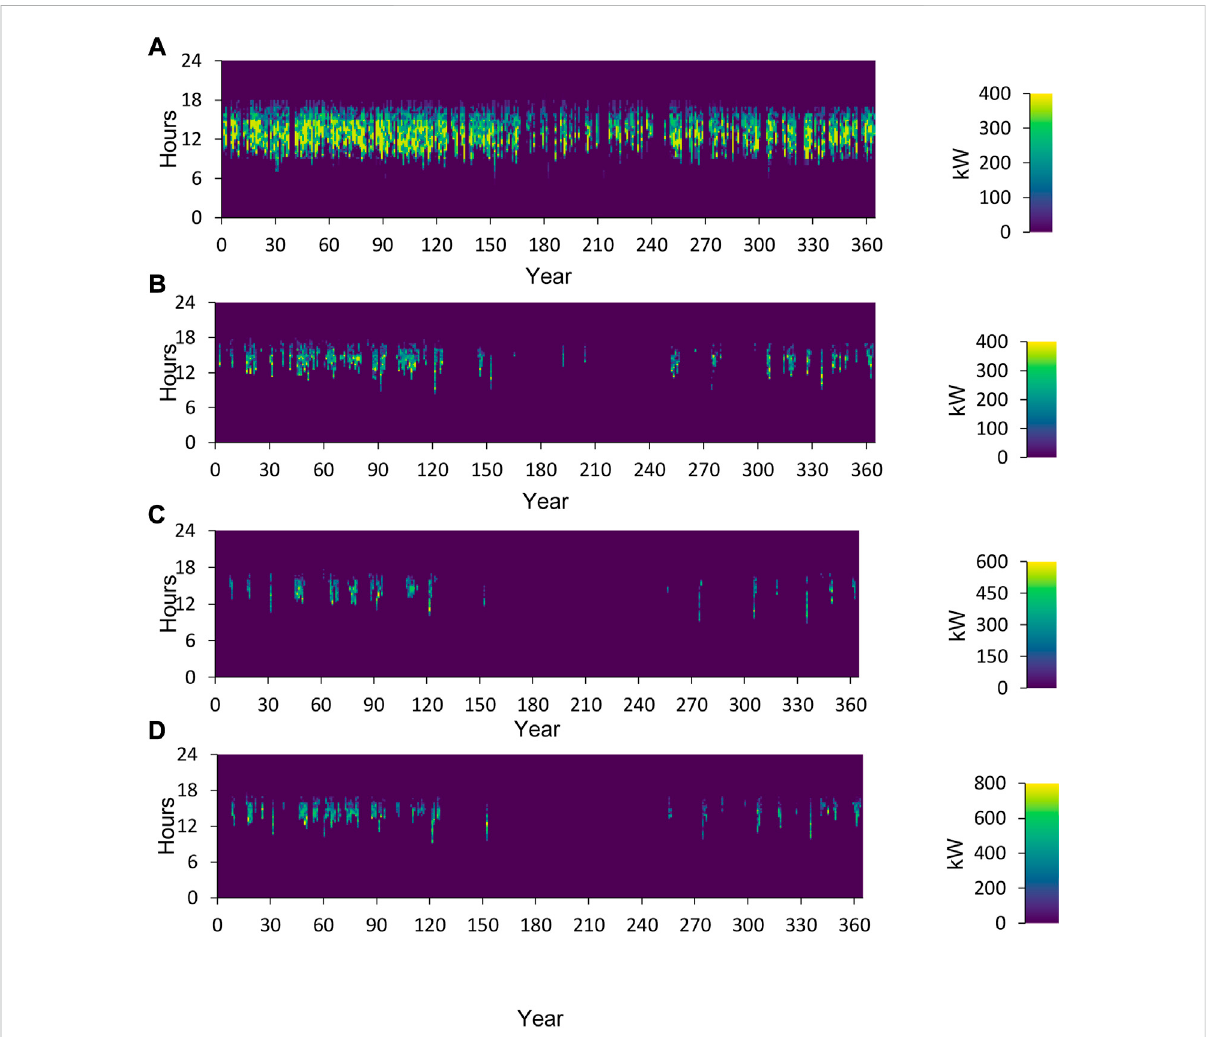
FIGURE 7 Power exports to the grid as per the scaled average daily sessions. (A) 10, (B) 20, (C) 30, and (D)